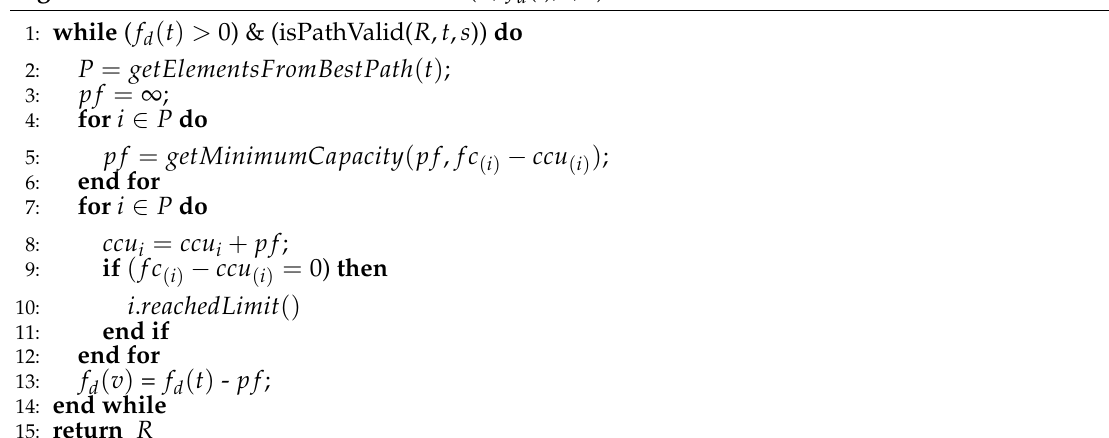
Algorithm 2 PLDA-D kernel calculations (R, f d (t), t,